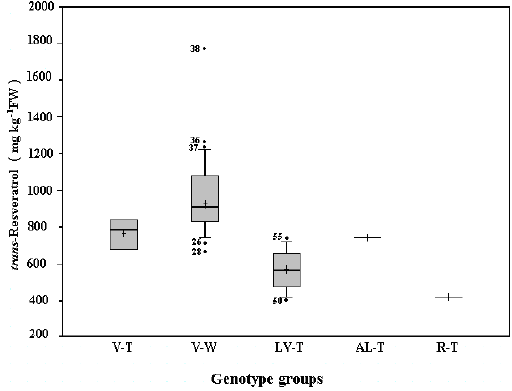
Figure 2. Box and whisker plots of Yangling Grape Germplasm Repository. The median and mean value are indicated by the horizontal bar and the plus sign inside the box, respectively; the height of the box represents the interquartile range (IQR), which is the difference between the third quartile and the first quartile of the data. The whisker (the vertical lines from the top and bottom of the box) extends to a distance of 1.5 times IQR. Data outside these whiskers are marked by the black dots. The numbers in front of the black dots represent the accession numbers (Table 1). V-T, table grape cultivars of V. vinifera ; V-W, wine grape cultivars of V. vinifera ; LV-T, table grape cultivars of hybrids between V. labrusca and V. vinifera ; AL-T, table grape of hybrid between V. aestivalis and V. labrusca ; R-T, table grape of V. rotundifolia .